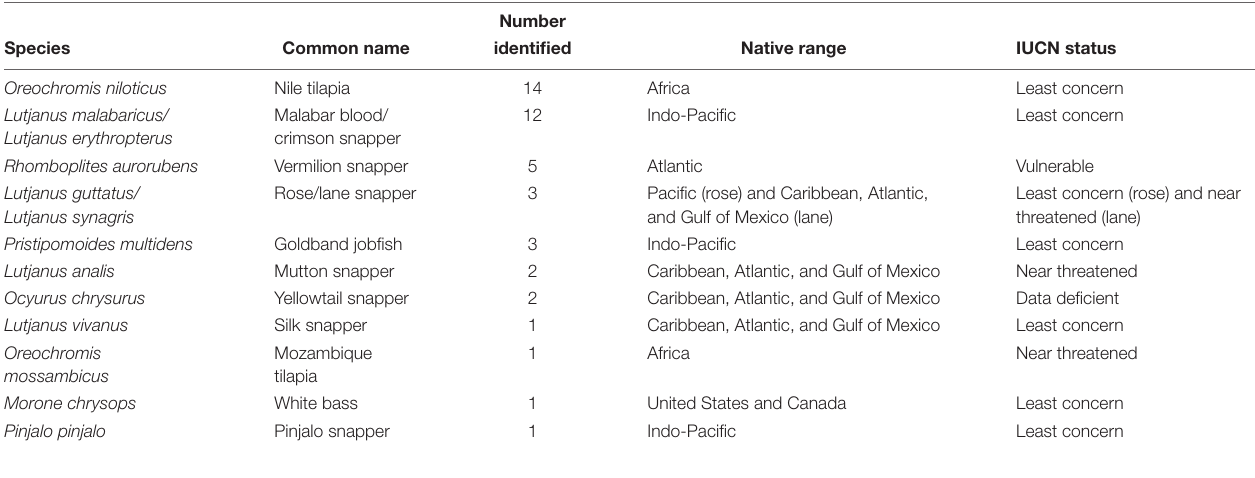
TABLE 1 | The name, range, and IUCN Red List status of species substituted for red